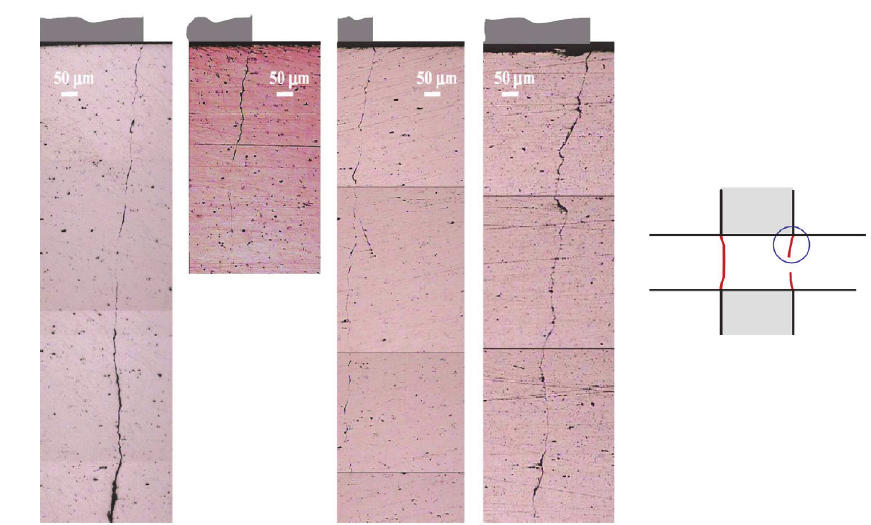
Figure 1: Micrographs for the propagation of non-failure cracks of four tests [1], emanating from the edge of